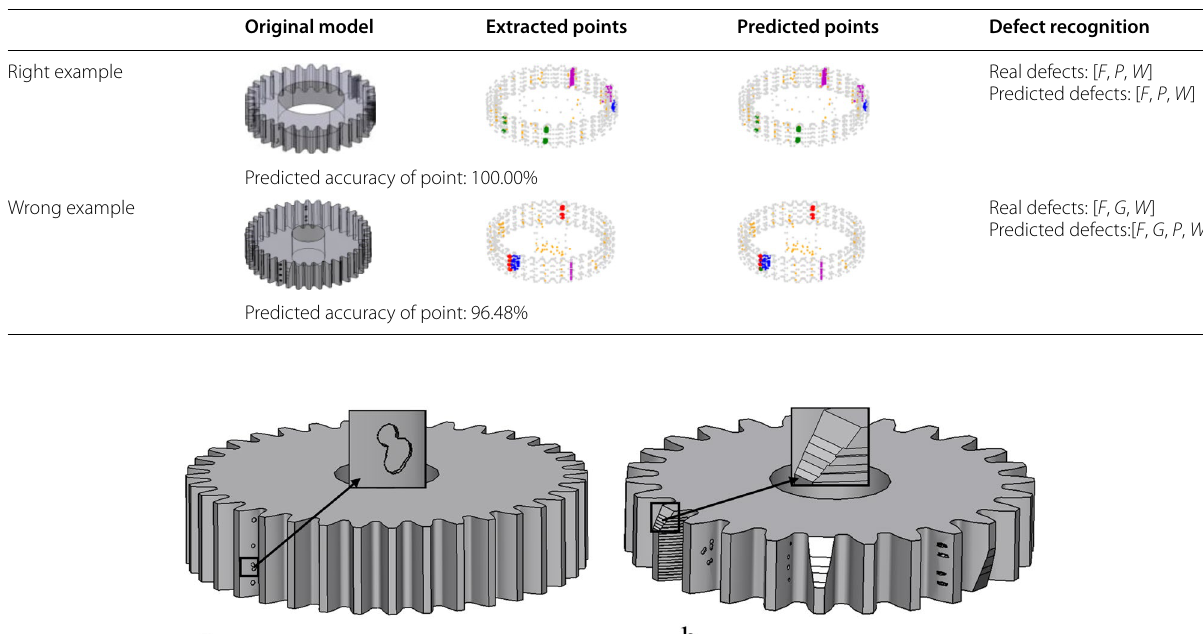
Table 6 Few recognition results and their original CAD models (point clouds)